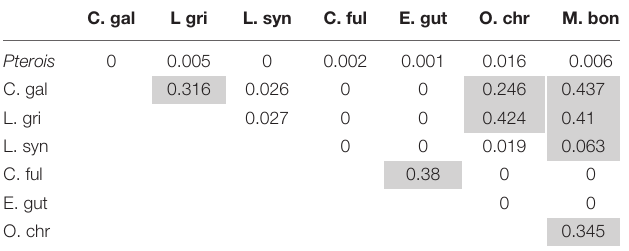
TABLE 4 | Results of Dunn’s test comparing δ 13 C between predators. C.